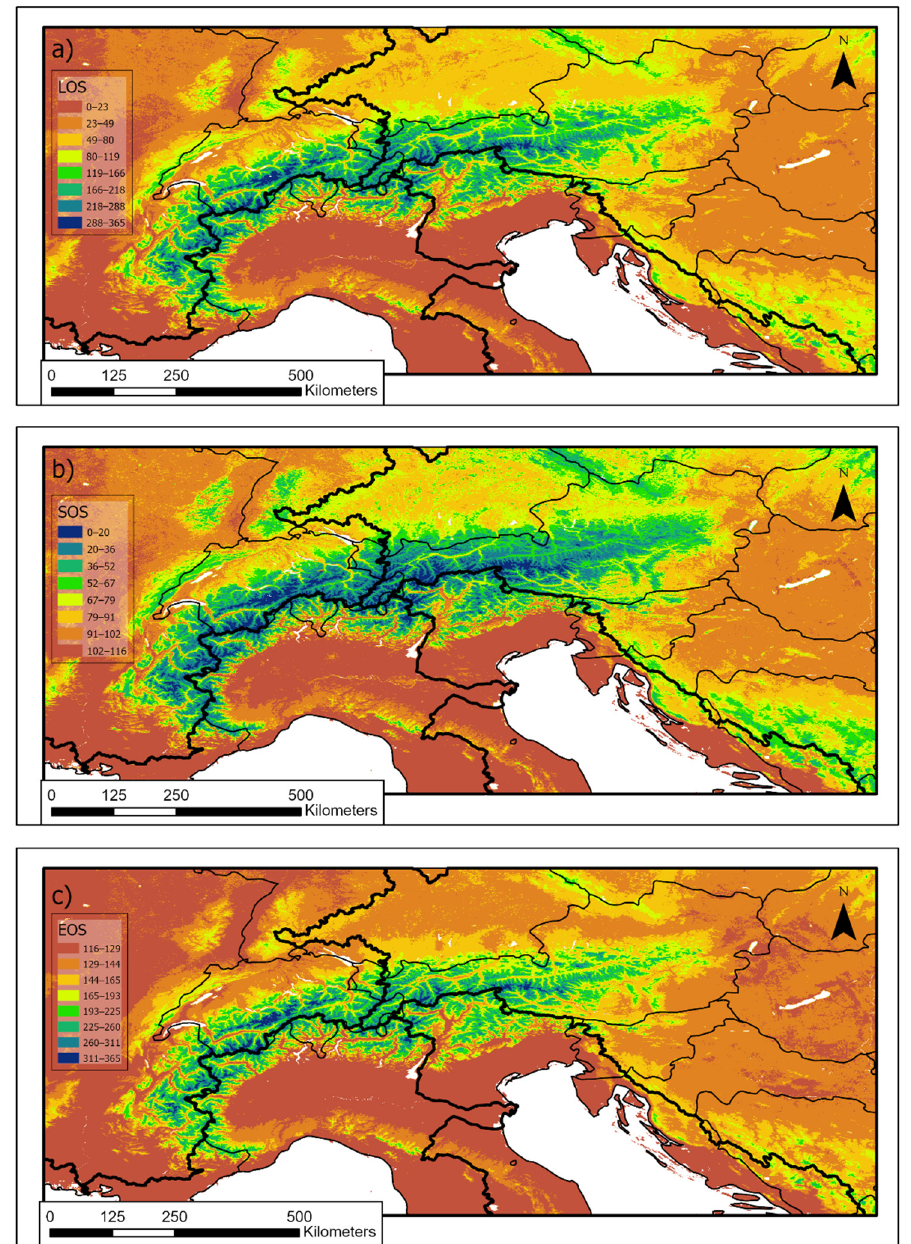
Figure 2. ( a ) Average length of the snow cover season expressed in days (LOS); ( b ) start of the snow cover season expressed in days from the 1st of October (SOS) and ( c ) end of the snow cover season expressed in days from the 1st of October (EOS) in the GAR during 2000–2019.